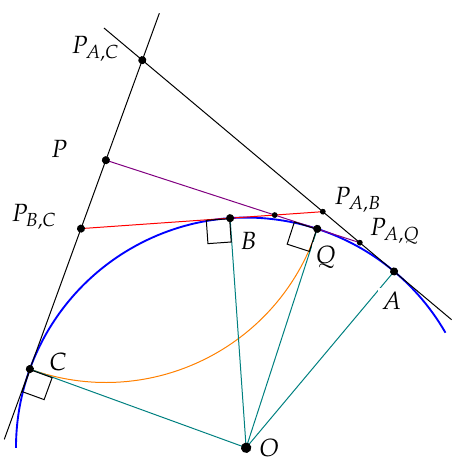
Figure 14. An order preserving